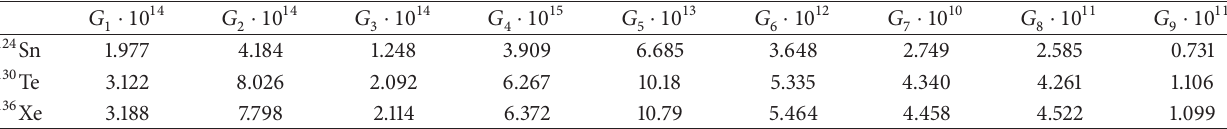
Table 2: The nine PSF expressed in [ yr −1 ] .